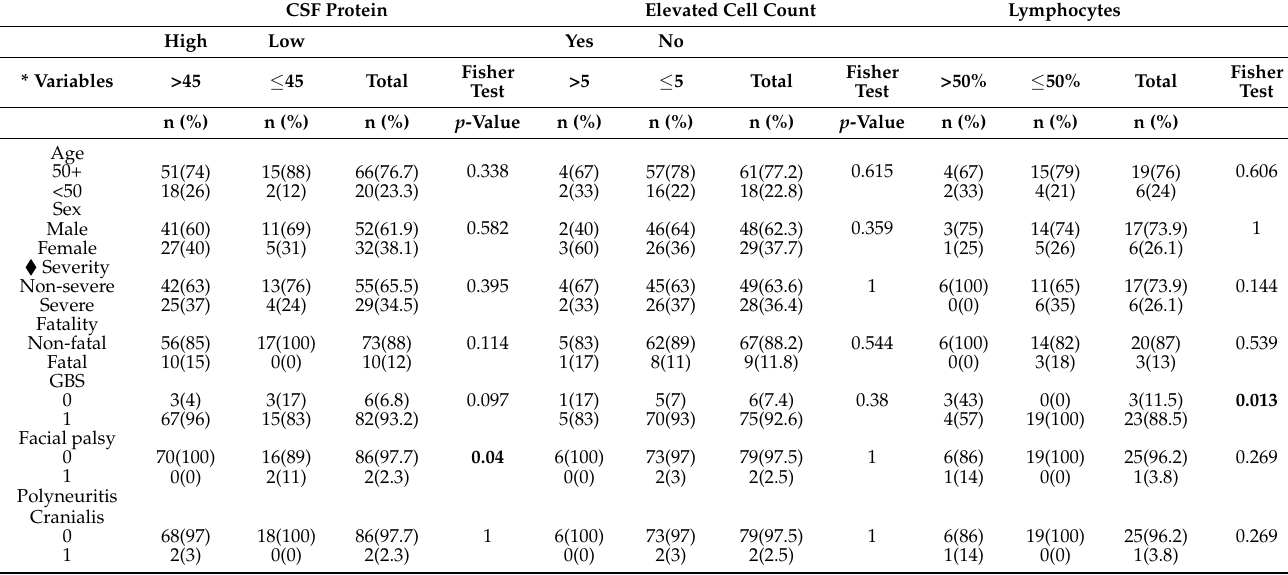
Table 7. Comparison of various PNS manifestation, demographics, severity and fatality by for CSF markers. CSF Protein Elevated Cell Count